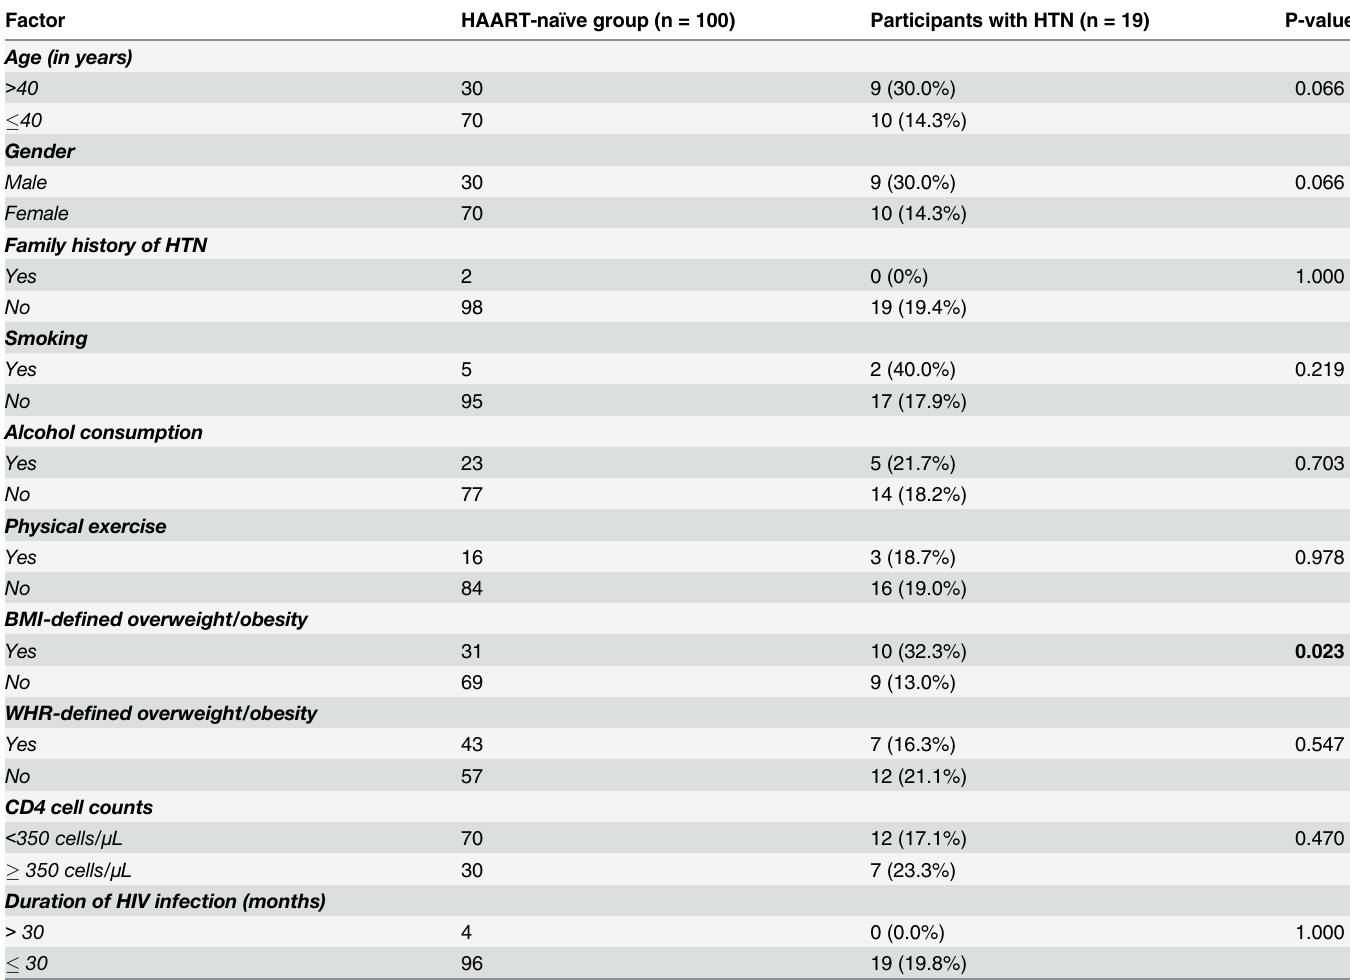
Table 4. Factors associated with hypertension in the HAART-naive group.